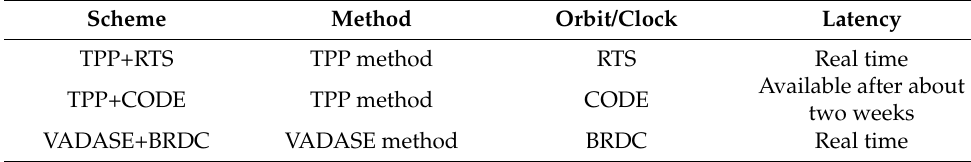
Table 1. Three processing